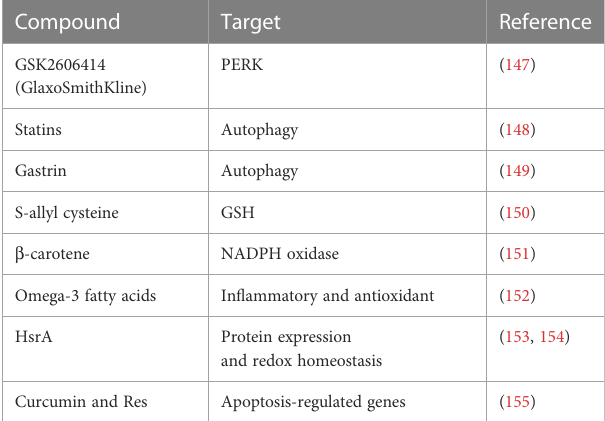
TABLE 3 Antioxidant therapy.